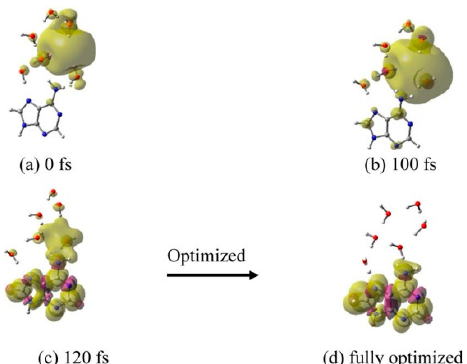
Figure 7. Total spin density plot of adenine (A)–6H 2 O • − at different times during MD simulation. ( a ) 0 fs (initial optimized starting structure for simulation), ( b ) 100 fs, ( c ) 120 fs, and ( d ) fully optimized structure. Structure d is stabilized by − 0.25 eV over structure a . Reprinted with permission from reference [72]. Copyright, 2016, American Chemical Society.